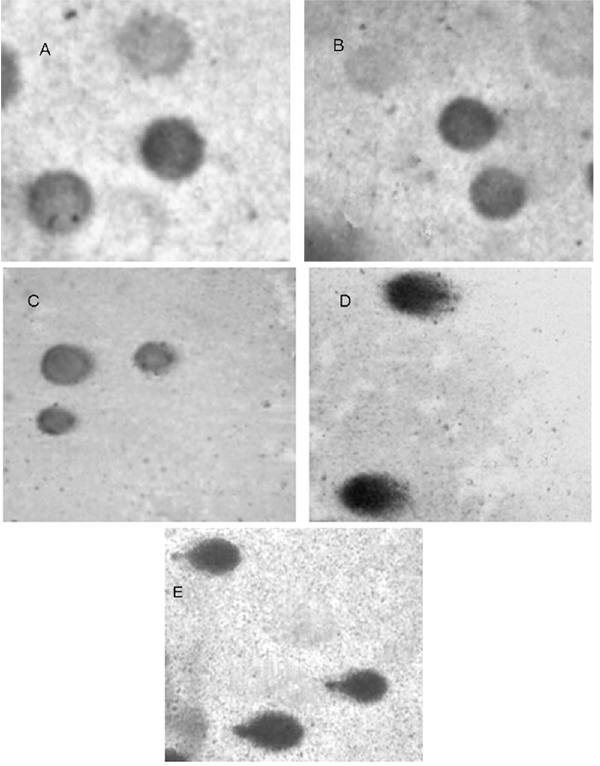
Fig 2. The result of single-cell gel electrophoresis. (A): negative control; (B)25% wastewater; (C) 50% wastewater; (D) 100% wastewater; (E) positive